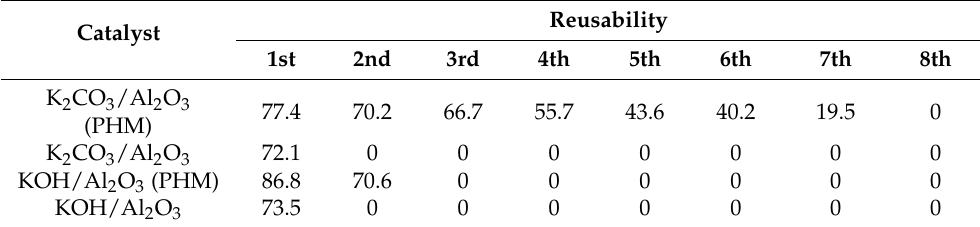
Table 2. The reusability study for beads catalyst with and without